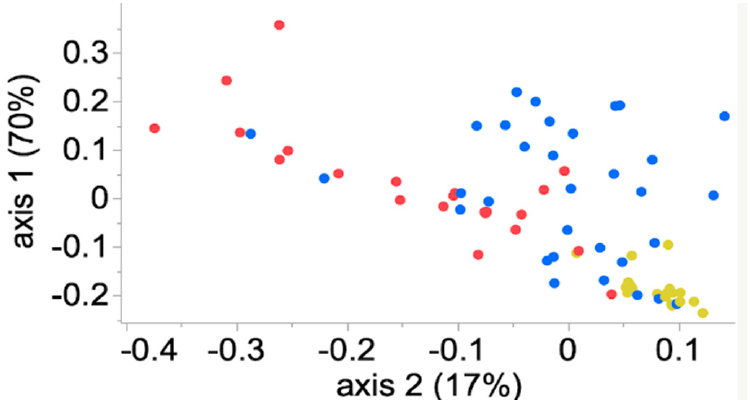
Figure 3. Scatter plot of the community membership (Jaccard index) of the equine fecal microbiota stored at ambient temperature for 0 h to 6 h (yellow), 12 h to 48 h (blue) and 72 h to 96 h (red) before freezing and sample processing.